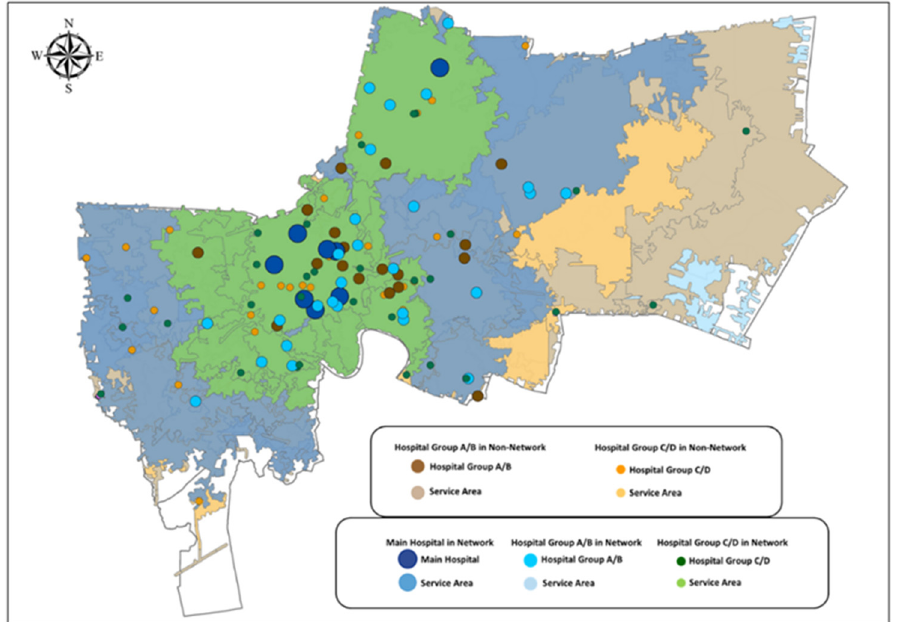
Figure 14. Service area of network hospitals.